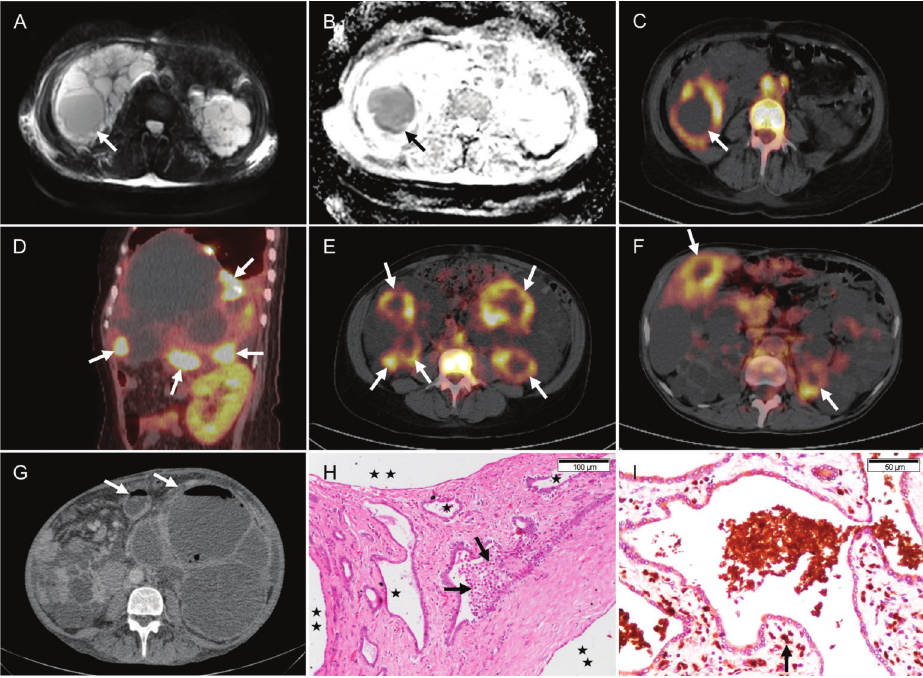
Figure 2. Cyst infection in autosomal dominant polycystic kidney disease/autosomal dominant polycystic liver disease (ADPLD) documented by several imaging methods ( A - G ) and histology ( H - I ). A - C , chronic kidney disease (CKD) stage 5 patient with kidney cyst infection (KCI). A , T2-weighted magnetic resonance imaging (MRI). Infected cyst in right kidney, axial plane (arrow). B , Diffusion- weighted MRI (DWMRI). Infected cyst in right kidney shows restriction to diffusion (arrow). C , positron-emission tomography/computed tomography (PET/CT). High correlation between T2-weighted MRI ( A ), DWMRI ( B ) and PET/CT in a CKD stage 5 patient with KCI (arrow). D , PET/CT. Multiple infected liver cysts after cyst fenestration in an ADPLD patient (arrows). E , PET/CT. Bilateral renal infected cysts (arrows), coronal plane. Imaging analysis reveals increased cyst-lining 18 FDG activity and signal accumulation within the cyst (inferior pole, right kidney). F , PET/CT. Concomitant kidney and liver cyst infection (arrows), axial plane. G , CT scan. Left kidney with emphysematous cyst infection (arrows), axial plane. H , Small liver cyst filled with neutrophils (arrows), small cysts containing no neutrophils (star), and large cysts lined by flat epithelium with no neutrophils (double stars; H&E, original magnification, 200 6 ,